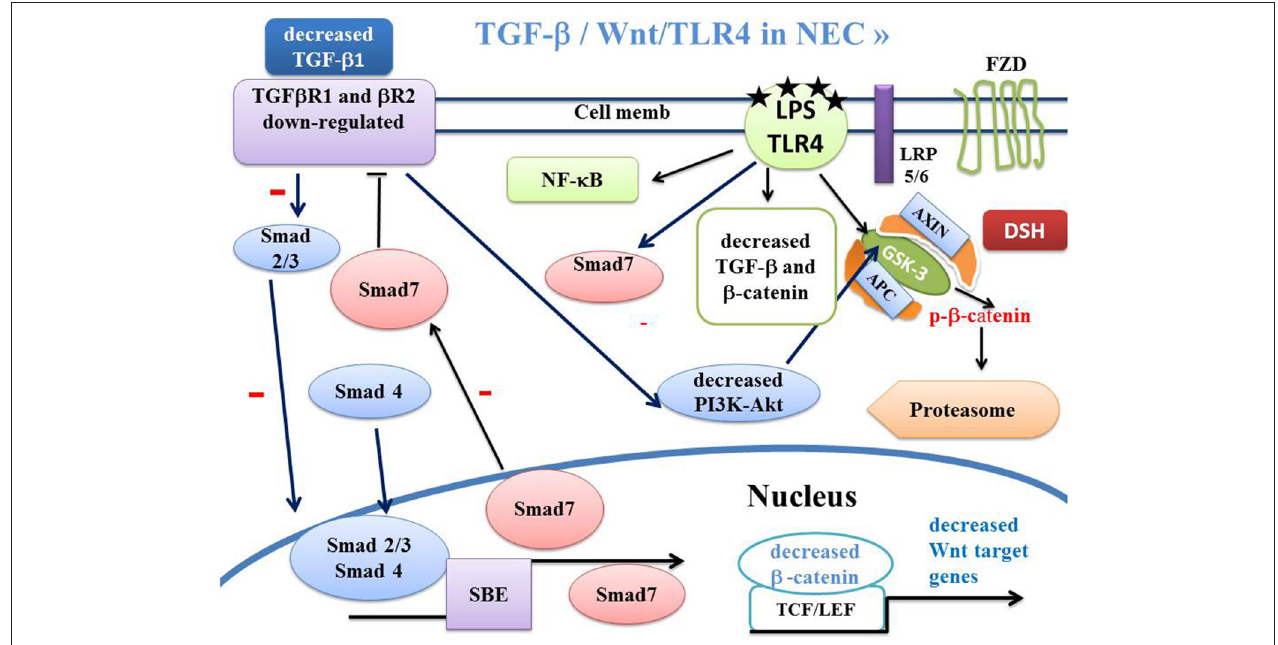
FIGURE 3 | Schema of canonical Wnt/ β -catenin, TGF- β , SMAD and PPAR γ pathways in NEC. In NEC, the LPS-TLR4 complex induces inactivation of TGF- β signaling. This leads to dephosphorylation of GSK-3 β , inducing β -catenin phosphorylation and β -catenin translocation into the proteasome. The LPS-TLR4 complex also inactivates the PI3K-Akt pathway leading to dephosphorylation of GSK-3 β and β -catenin translocation to the proteasome. APC, adenomatous polyposis coli; DSH, Disheveled; FZD, Frizzled; GSK-3 β , glycogen synthase kinase-3 β ; LRP5/6, low-density lipoprotein receptor-related protein 5/6; PPAR γ , peroxisome proliferator-activated receptor gamma; PI3K, phosphatidylinositol 3-kinase; Akt, Akt/Protein Kinase B; TCF/LEF, T-cell factor/lymphoid enhancer factor; TGF, Transforming Growth Factor; SBE, Smad binding element.